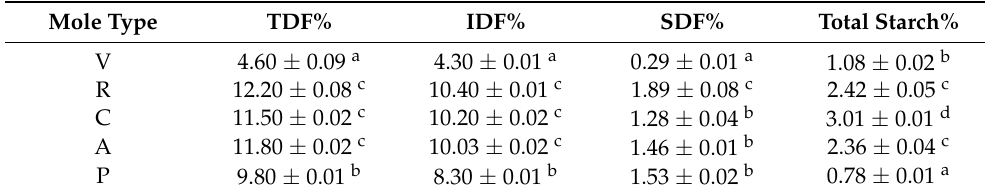
Table 4. The total soluble and insoluble dietary fiber content of five varieties of mole from the State of Hidalgo.